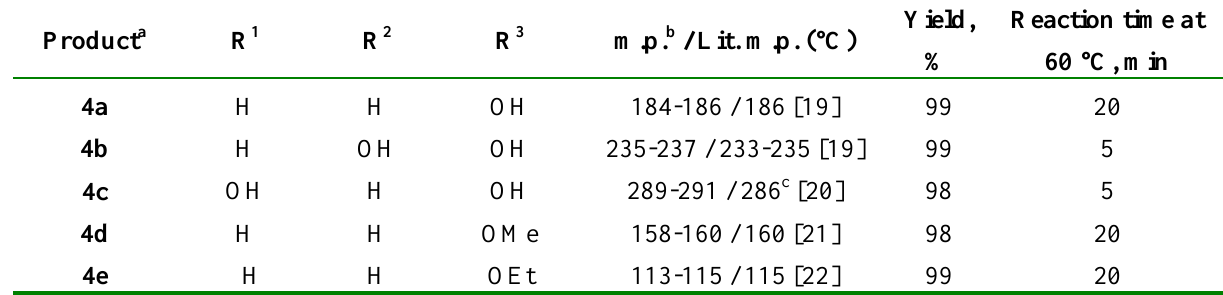
Table 1. Substituted 4-methylcoumarins 4a-e produced via Scheme